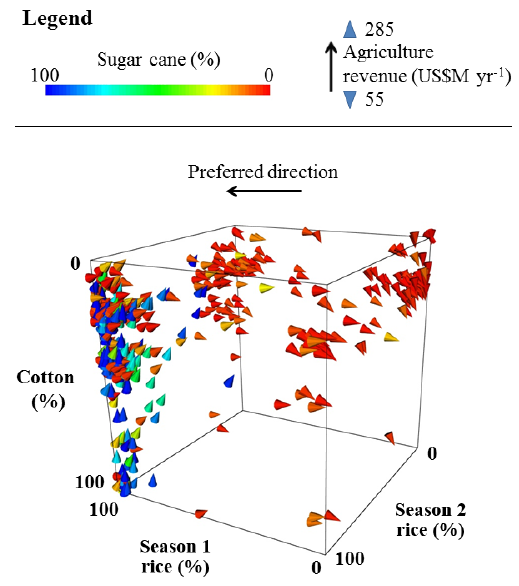
Figure 8. 3-D (non-trade-off) plot showing the relationship between irrigation scheme selection and agricultural revenue. The solution points are the same as those shown in Fig. 7. High revenues can be achieved with or without the implementation of the cotton scheme. A high proportion of all other schemes must be implemented to achieve maximum revenue,